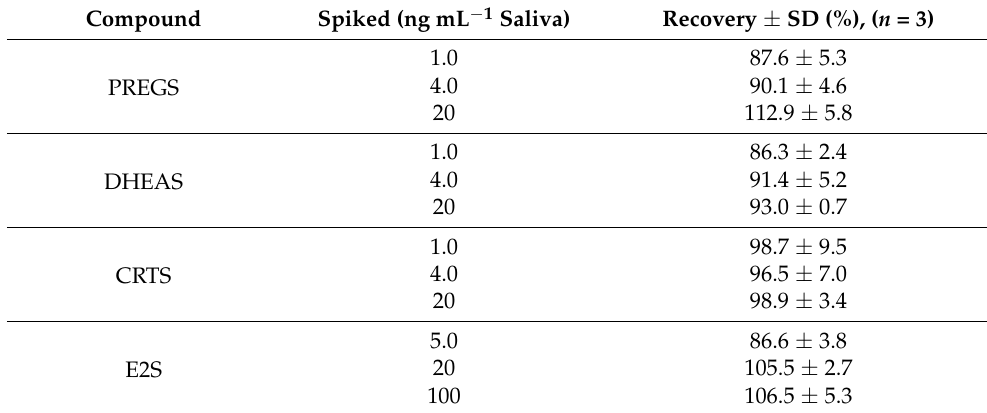
Table 3. Recoveries of sulfated steroid metabolites spiked into saliva samples.